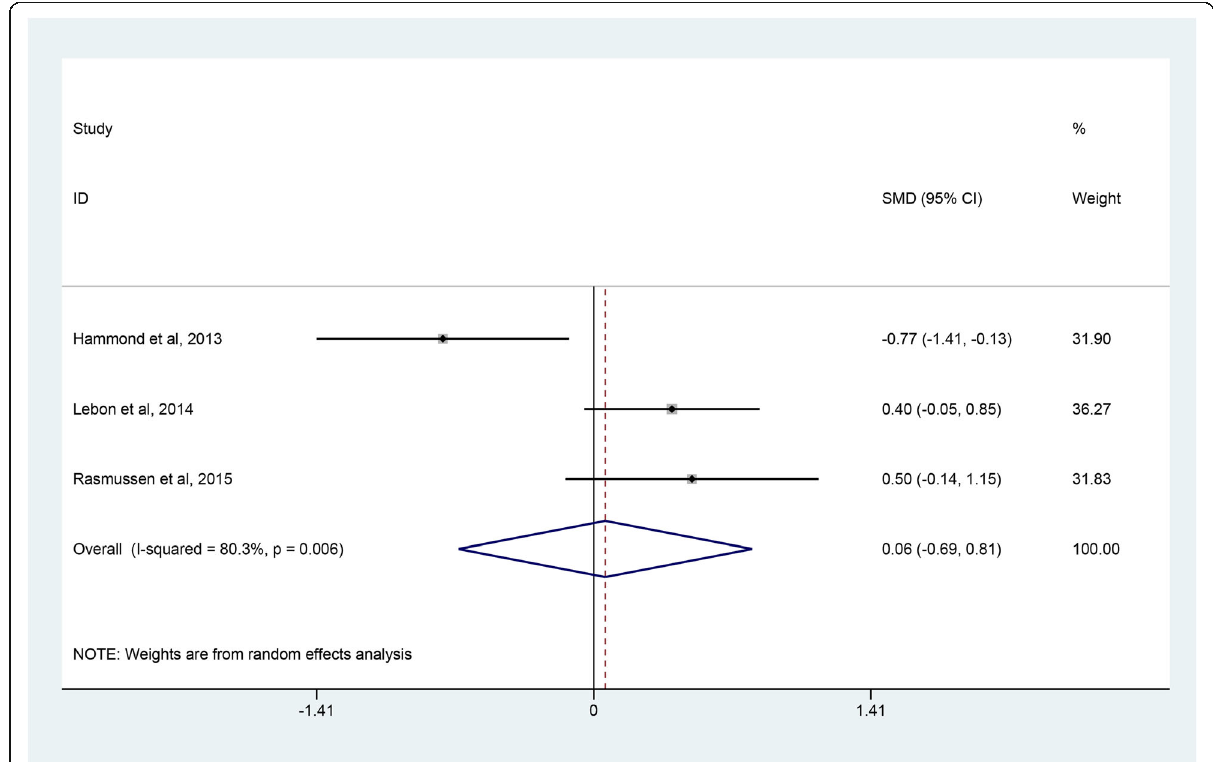
Fig. 3 Forest plot comparing CMS scores after resurfacing hemiarthroplasty (RHA) versus stemmed hemiarthroplasty